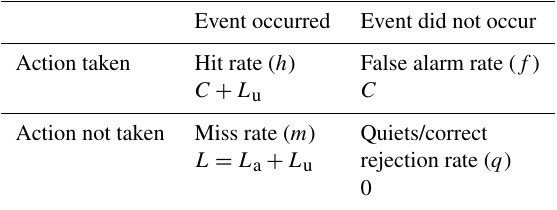
Table 1. Contingency table for the cost–loss decision problem with expenses from each possible combination of action and occurrence. Here, C is the cost of the mitigating action, L u is the unavoidable portion of loss L from the event occurring, and L a is avoidable por- tion of loss from the action.